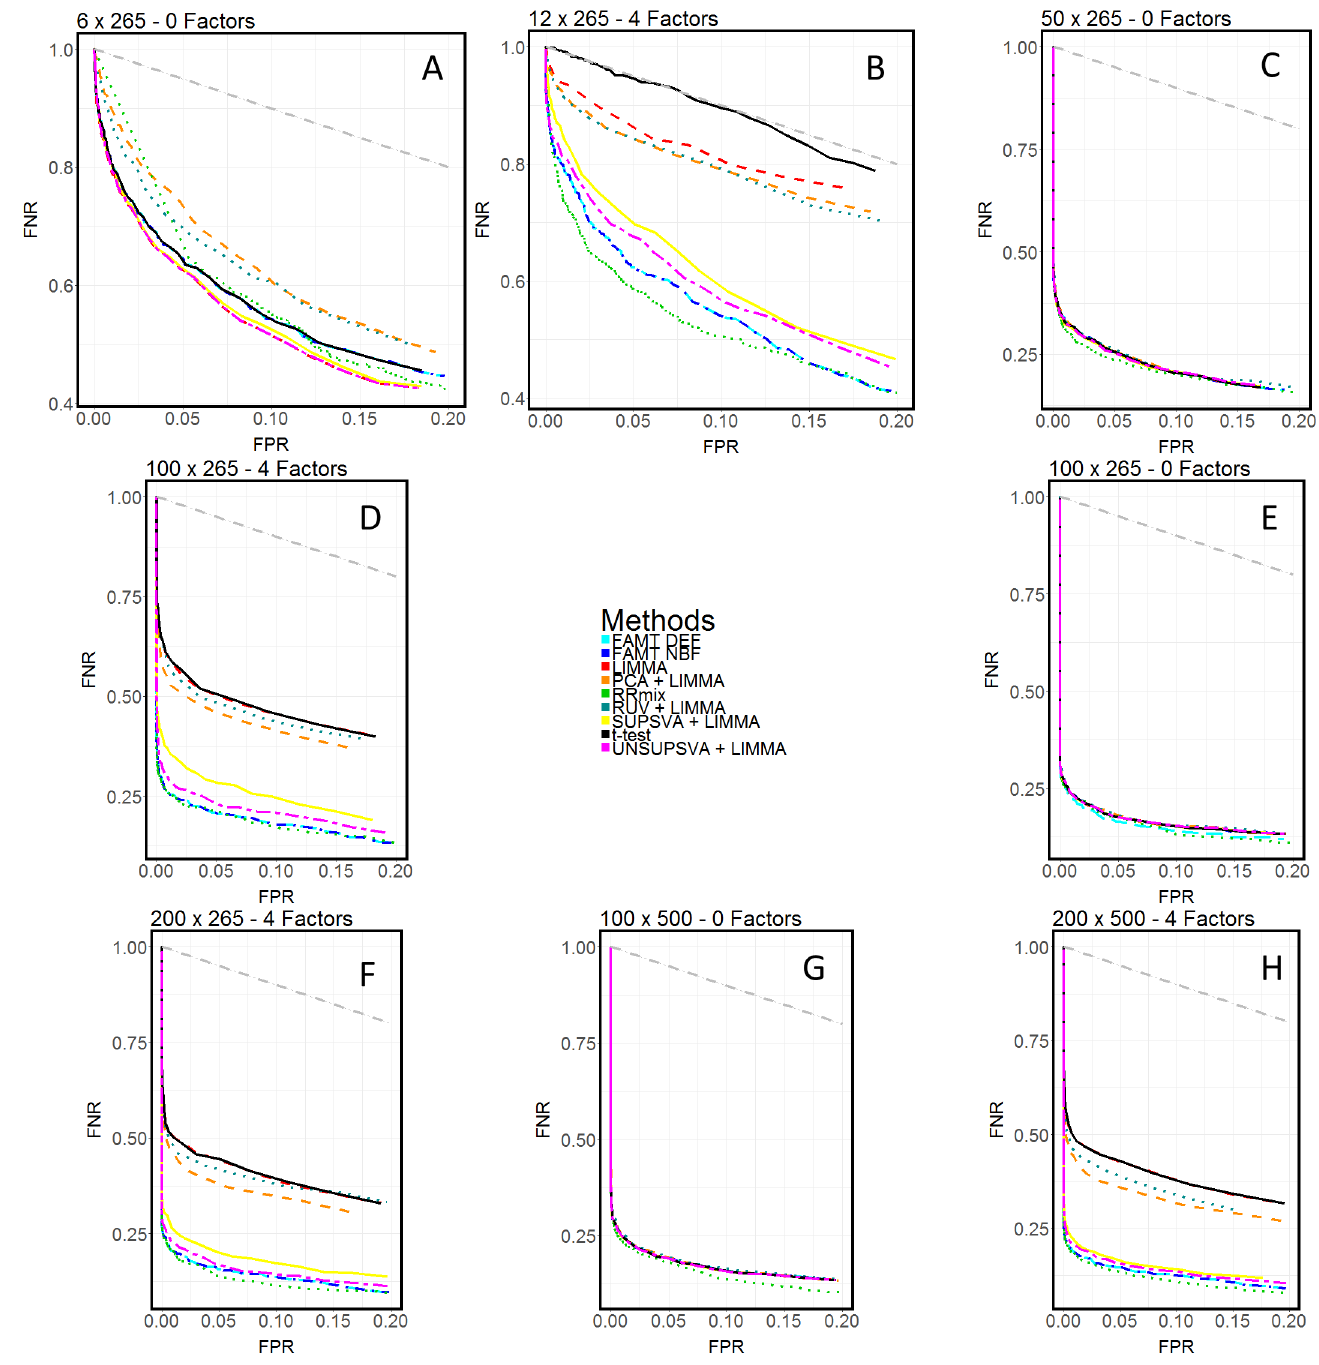
Fig 4. Evaluation of DET using